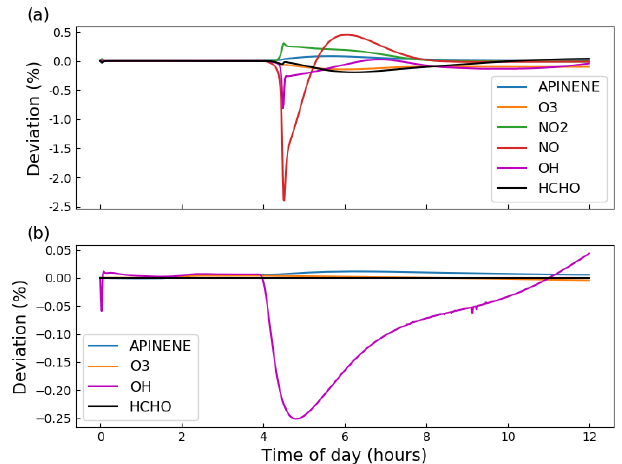
Figure 3. Gas-phase photochemistry verified; simulations of photo- chemistry in an aerosol chamber exposed to natural light, for which deviation is defined in Eq. (4). α -Pinene ozonolysis is simulated in both plots, with α -pinene and O 3 given the same initial concen- trations of 21.1ppb; initial NO x concentrations of (a) 9.8ppb and (b) 0ppb. For both simulations, the aerosol chamber is transparent and exposed to daylight without cloud interference, with dawn at approximately 4h. Gas–wall partitioning is turned off in PyCHAM to be consistent with the AtChem2 model, and no particles are present in either